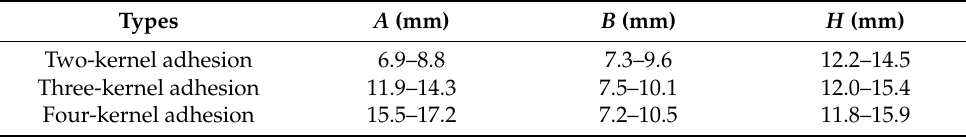
Table 8. Types and characteristic dimensions of adhesive kernels.